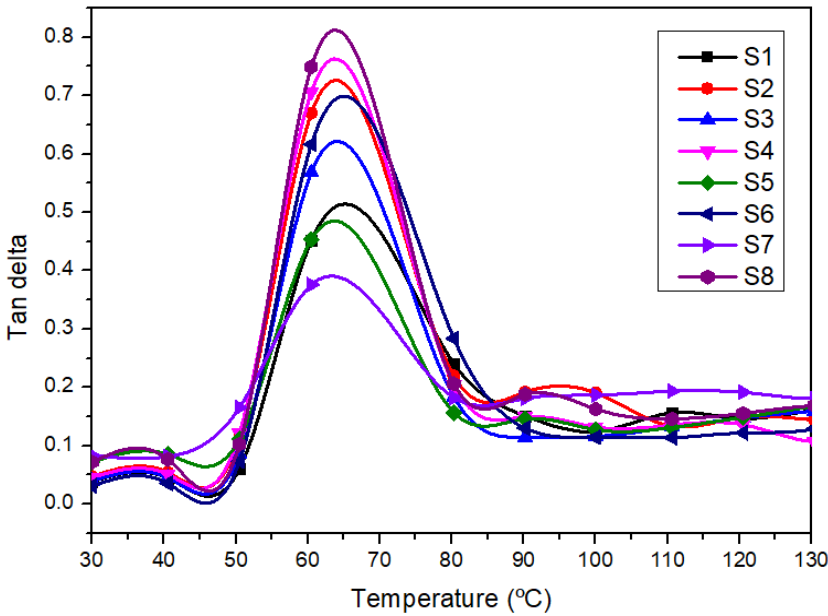
Figure 7. The Tan δ curves of different laminated composites.